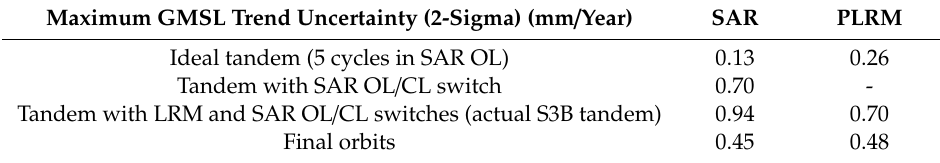
Table 3. Maximum GMSL trend uncertainty (mm / yr) resulting from the S3A / B bias uncertainty for various